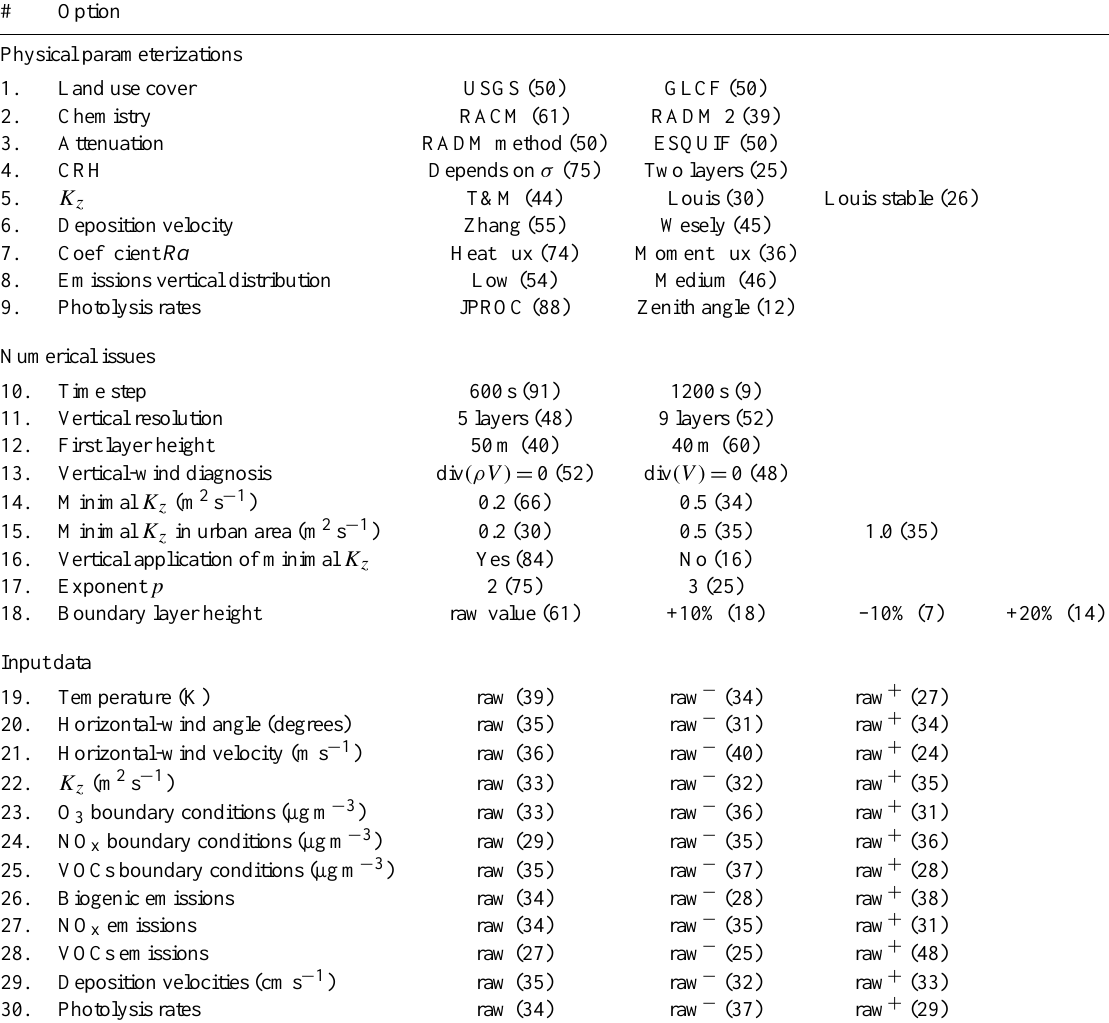
Table 3. Occurrence frequency of each parameterization, numerical option and field perturbation for the 101-member ensemble. As for the perturbations, “raw” means no perturbation, “raw − ” means lower value after perturbation ( p/α or p − α ) and “raw + ” means higher value after perturbation ( pα or p + α